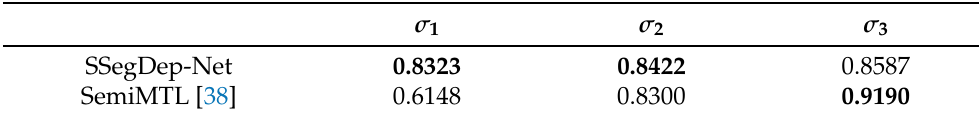
Table 7. Quantitative results using the threshold metric σ (see the Appendix A). Higher values are